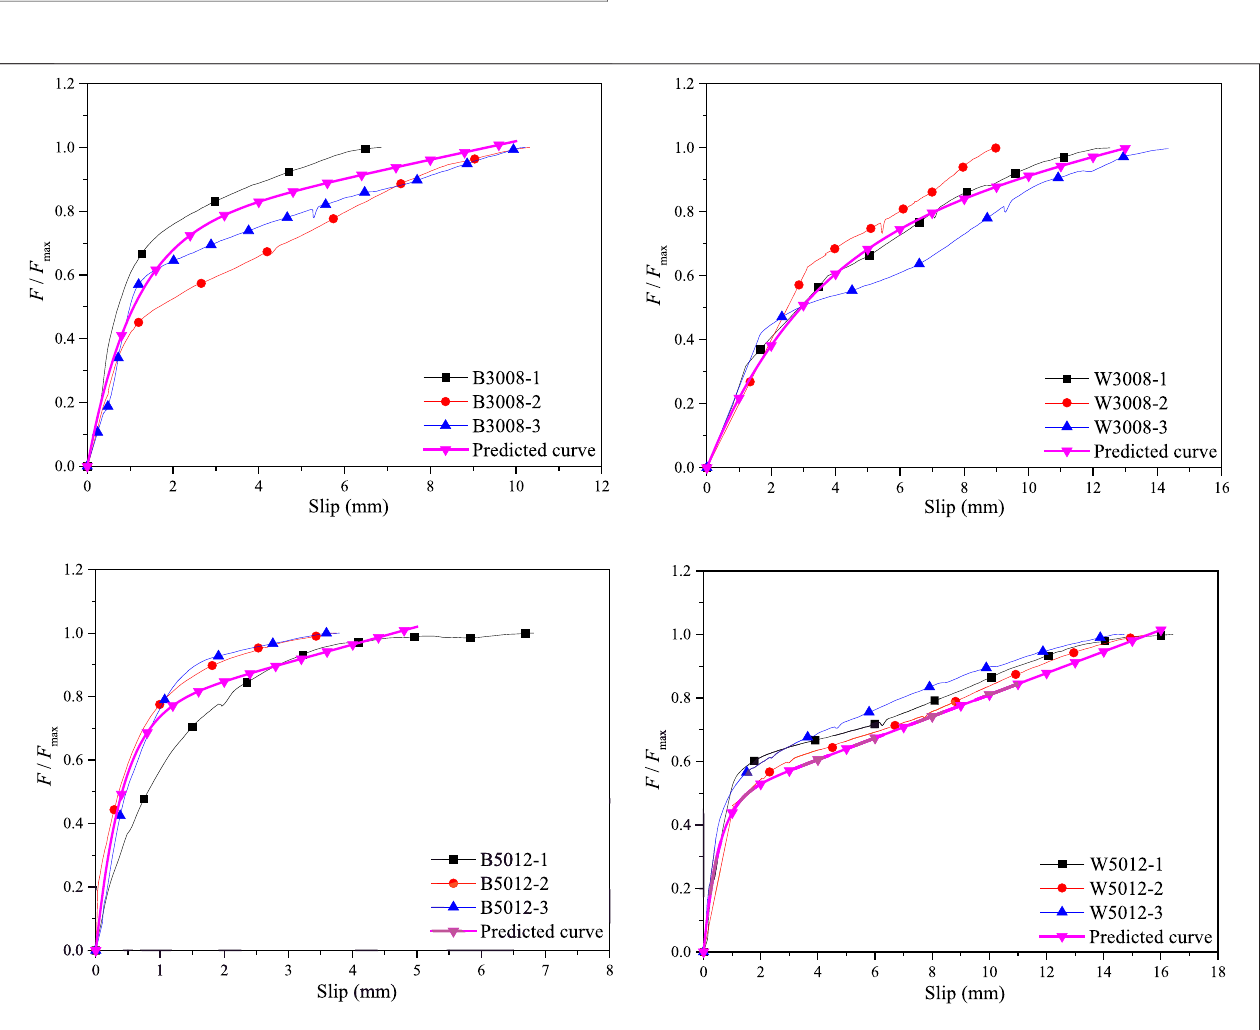
FIGURE 18 | Predicted curve and test curve. (A) B3008, (B) W3008, (C) B5012, (D) W5012.